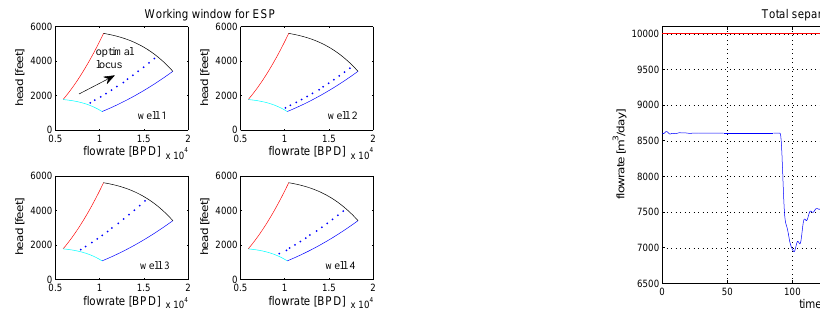
Figure 5: Total fluid flow illustrating that the system exhibits inverse response characteristics a waste of energy consumed by the